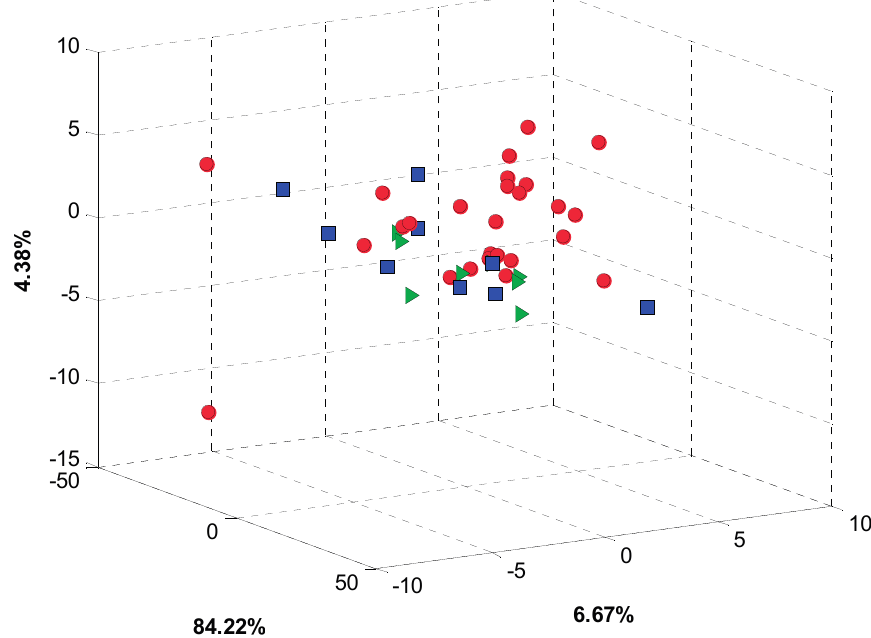
Figure 3. Coffee data representation by its three first principal components. Red dots represent HGC, blue squares represent samples OC coffee and green triangles represent samples OPW